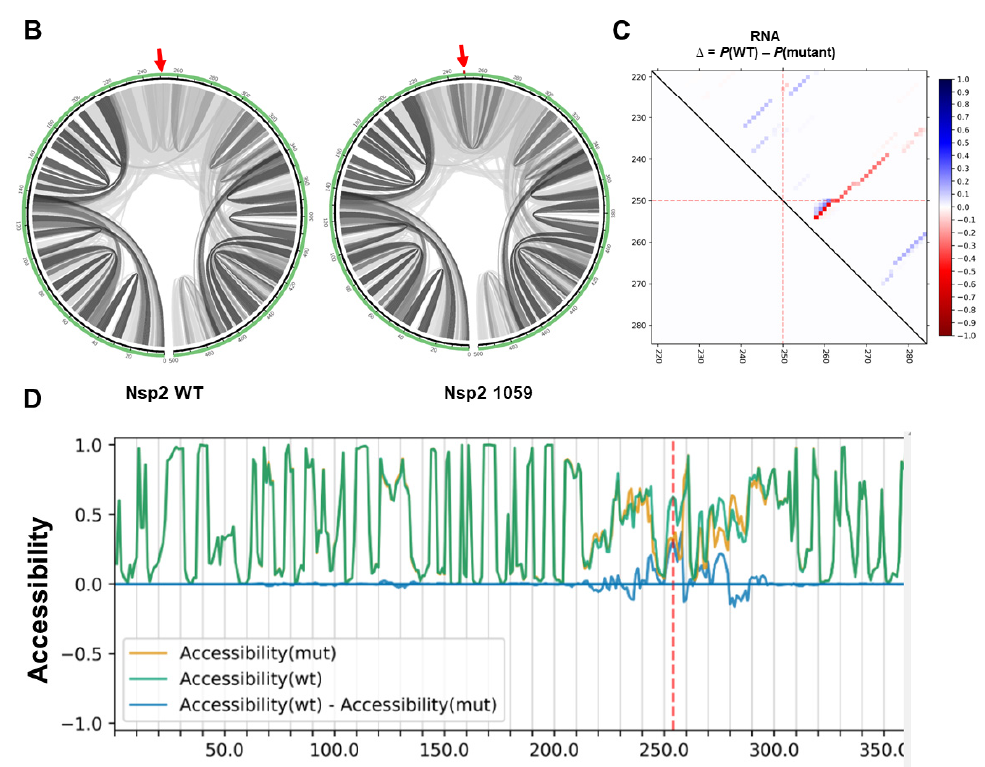
Figure 2. The impact of C1059U mutation on local RNA secondary structure of Nsp2. ( A ) RNA secondary structures of Nsp2 wild type (MFE structure: − 146.10 kcal/mol—centroid structure: − 132.30 kcal/mol) and 1059 mutation (MFE structure: − 147.20 kcal/mol—centroid structure: − 137.80 kcal/mol) using RNAfold tool. ( B ) The base pair probabilities by circular plots with higher base pairing potential is reflected in darker hues of grey lines and the mutated position highlighted by red arrow (MutaRNA). ( C ) The dot plot shows the differences of the base pairing probabilities of 1059 mutation vs. wild type RNA, Pr(bp in WT)—Pr(bp in mut). The base pairs weakened by the 1059 mutation are in blue, while higher base pair probability in the mutant is depicted in red. The mutated position is highlighted by red dotted lines (P values based on RNAsnp are as follows: mode-1 = 0.2617, mode-2 = 0.3344). ( D ) The accessibility profiles of wild type (green line) and the mutation (yellow line) and their di ff erences provide an assessment of the mutation e ff ect on the RNA single-strandedness, which may relate to its interaction potential with other RNAs or proteins. Accessibility is measured in terms of local single-position unpaired probabilities and is plotted as WT—Mut, whereby a negative value indicates increased accessibility caused by the mutation [45]. The mutated position is highlighted by a red